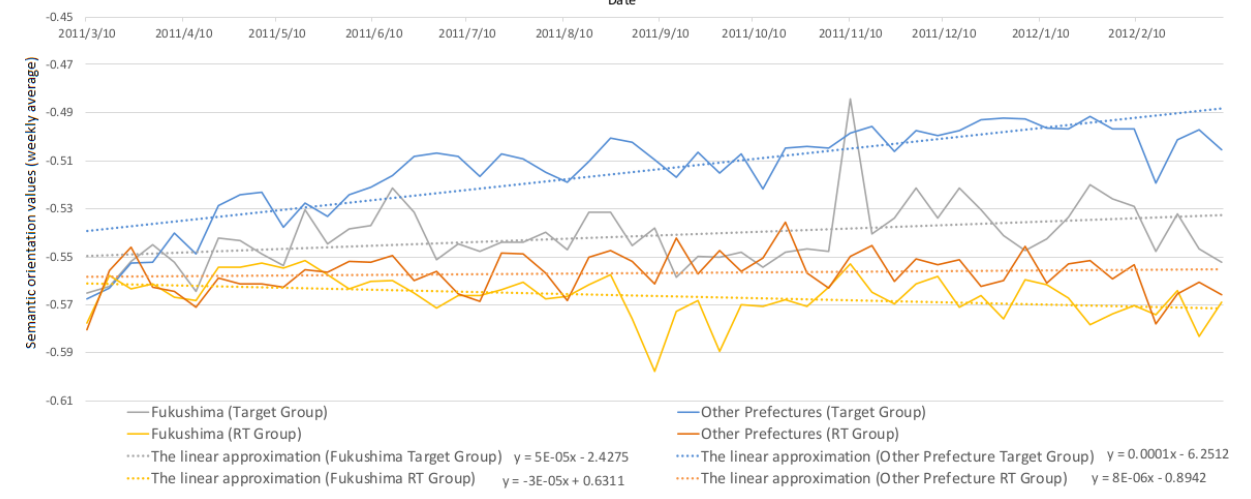
Figure 9. Weekly average of semantic orientation values for Fukushima Prefecture and other prefectures. RT: